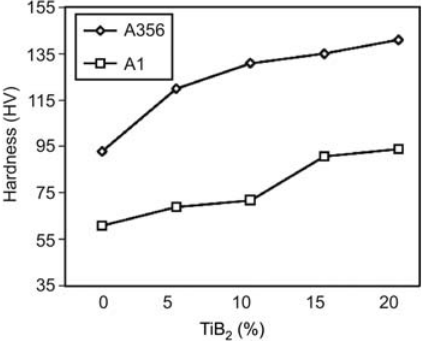
Figure 3 Hardness values of Al and A356 matrix